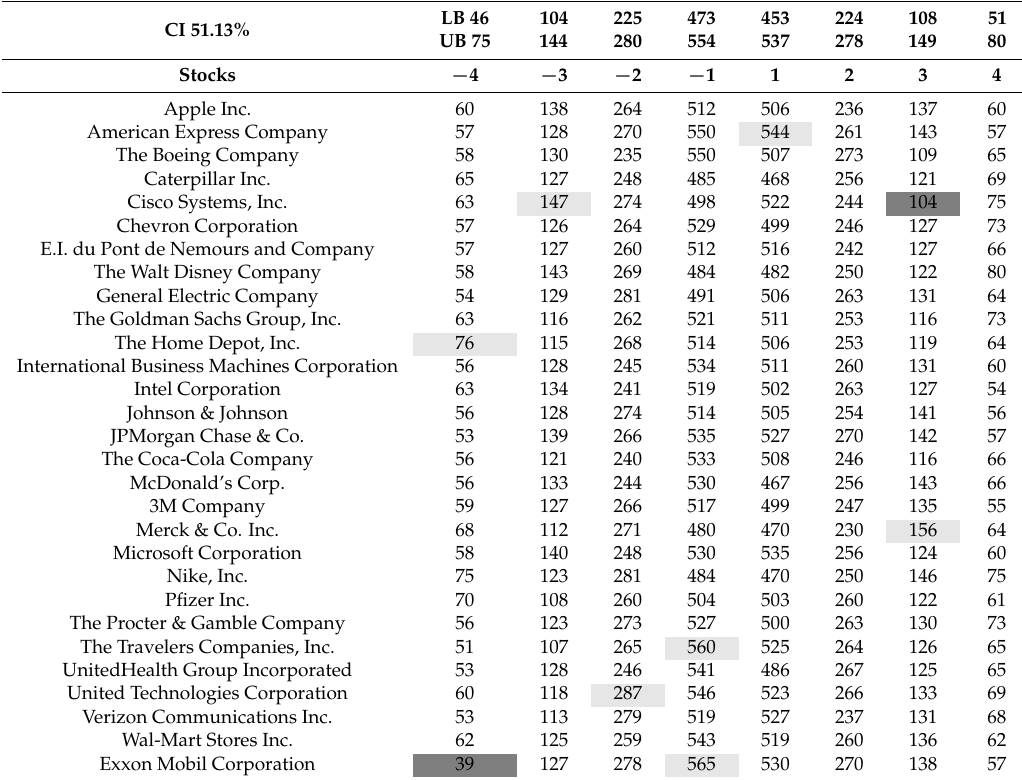
Table 5. ( A ) Number of Runs in the Middle of the Distribution (n between − 4 and +4) for Dow Jones Stocks. ( B ) Number of Runs in the Tails of the Distribution (|n| equal to or greater than 5) for Dow Jones